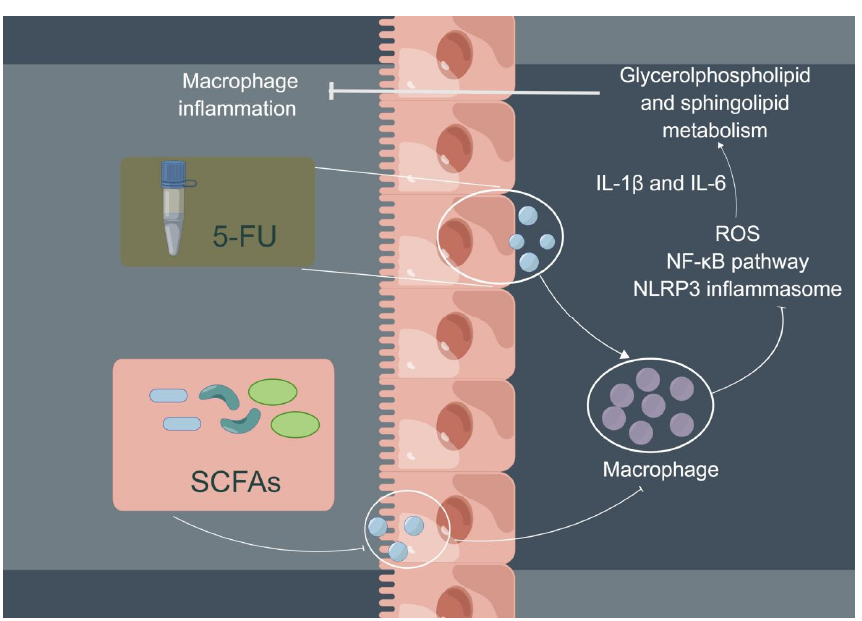
Figure 8. Potential mechanism of intestinal SCFAs inhibiting 5-FU-induced macrophage inflamma- tion. 5-FU can activate intestinal mucosal macrophages, and activated macrophages secrete a large number of pro-inflammatory cytokines to cause intestinal mucosal damage (chemotherapy intestinal mucositis). SCFAs are beneficial metabolites produced by bacteria in the gut. Three main SCFAs (acetate, propionate, and butyrate) inhibited 5-FU-induced THP-1 cell inflammation and reduced pro-inflammatory cytokine expression (IL-1 β and IL-6) via inhibiting NF- κ B signaling pathway and NLRP3 inflammasome activation by regulating glycerolphospholipid and sphingolipid metabolism.